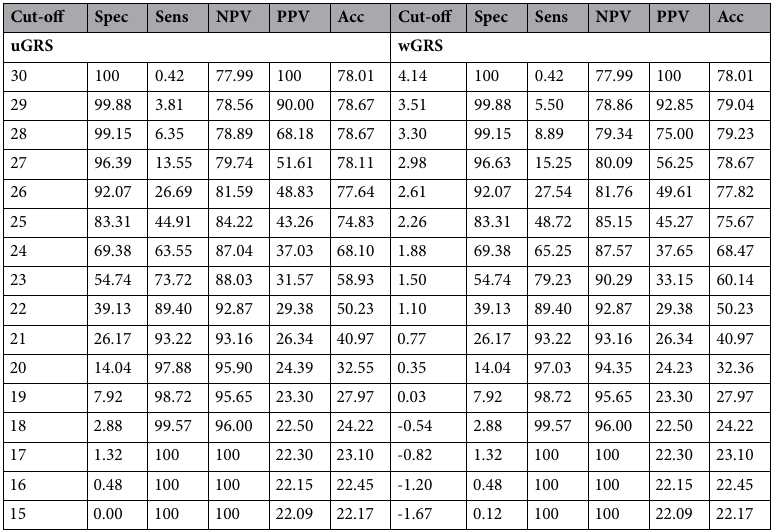
Table 3. Specificity, sensitivity, negative and positive predictive value and accuracy analysis presented in percentages (%). Abbreviations: uGRS (Unweighted Genetic Risk Score); wGRS (Weighted Genetic Risk Score); Acc (accuracy); NPV (negative predictive value); PPV (positive predictive value); Sens (sensitivity); Spec